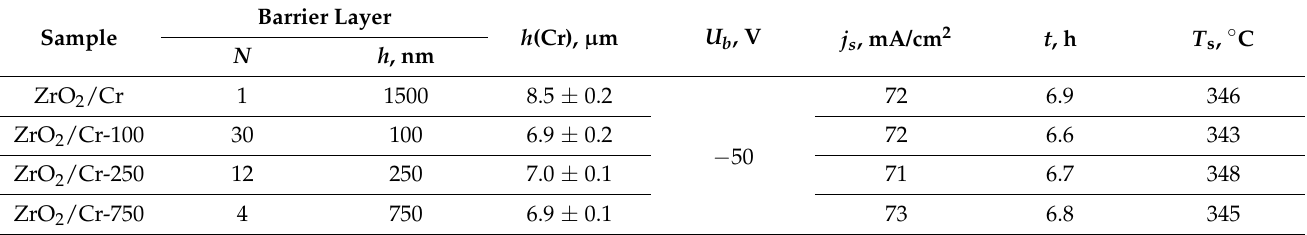
Table 1. The deposition conditions of the ZrO 2 /Cr